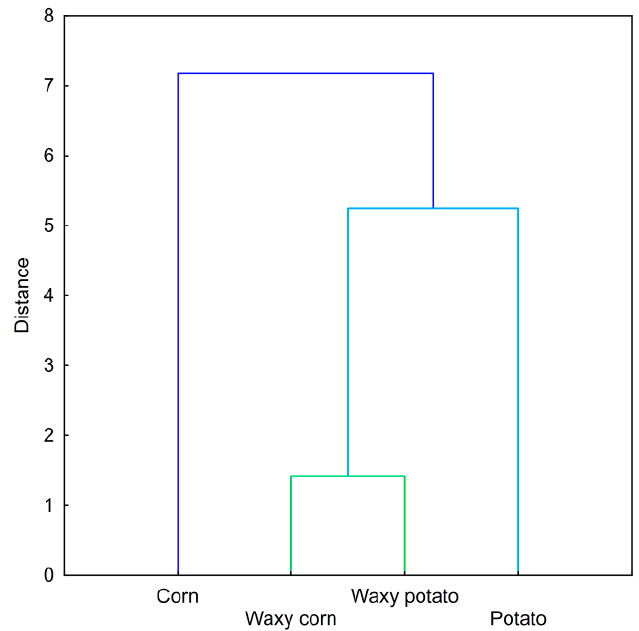
Figure 2. Dendrogram; hierarchical cluster analysis of 5% native starch pastes.